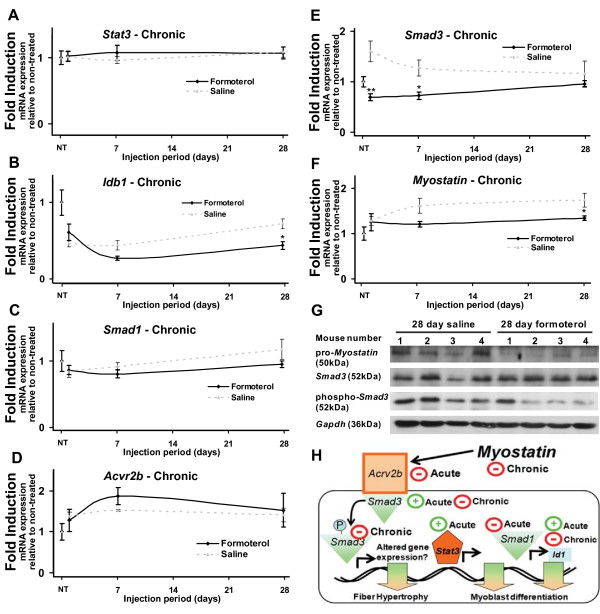
Chronic systemic administration of formoterol alters the expression of genes associated with skeletal muscle hypertrophy and myogenesis at multiple timepoints. Quantitative RT-PCR was used to assay the expression of A. Stat3, B. Idb1, C. Smad1, D. Acvr2b, E. Smad3, and F.Myostatin mRNAs in tibialis anterior over chronic timepoints. Muscles were removed at 1, 7 and 28 days following daily intraperitoneal injection of formoterol or saline vehicle (NT = no treatment). Results were normalized against 36B4 at each timepoint. Data are expressed as mean ± SEM (n = 5). Statistical significance was assessed using a one-way ANOVA with Bonferroni's post-test where p < 0.05 (*), p < 0.01 (**) and p < 0.001 (***). Unmarked data points are non-significant. G. Protein levels of Myostatin precursor (pro-Myostatin), Smad3, phosphorylated Smad3, and Gapdh were visualized by Western blotting performed on tibialis anterior muscle following 28 days of formoterol/saline administration in four animals for each treatment. H. Diagrammatic representation of acute and chronic gene expression changes related to skeletal muscle hypertrophy and myogenesis in response to formoterol.